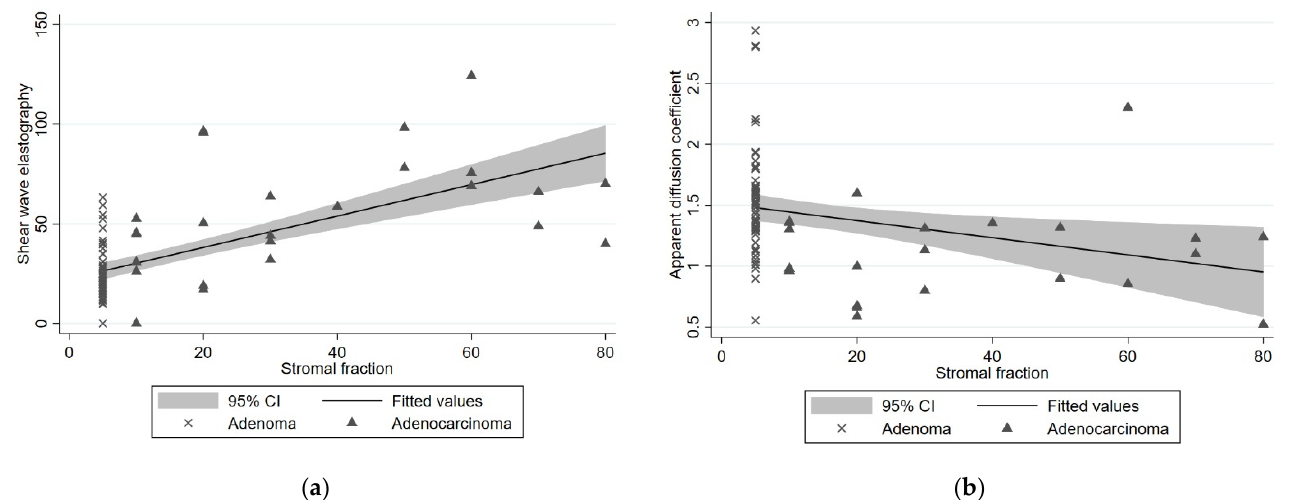
Figure 6. Plots showing the correlation between stromal fraction (SF) and shear-wave elastography (SWE) and between SF and apparent diffusion coefficient (ADC). Each point is plotted as the per- centage SF and the corresponding value of SWE or ADC. The line represents the fitted values, and the grey area represents the 95% confidence interval. ( a ) Correlation between SF and mean SWE values in kPa. There is a positive correlation with a p -value of <0.001. ( b ) Correlation between SF and ADC values in 10 − 3 mm 2 /s. There is a negative correlation with a p -value of